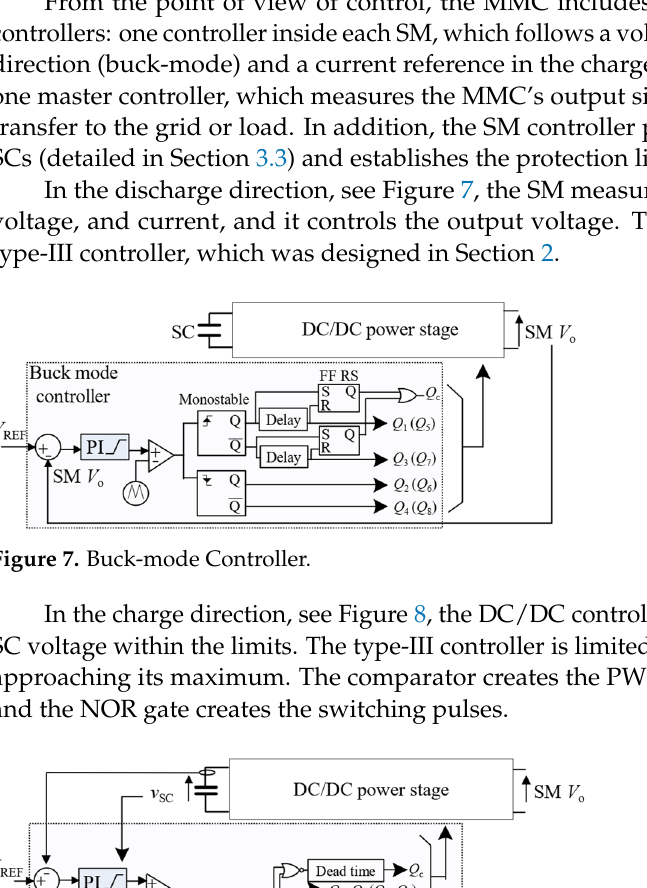
Figure 8. Boost-mode controller.